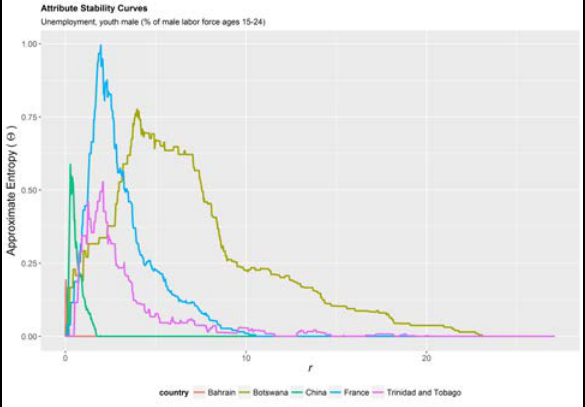
Figure 2. Attribute Stability Curves of Examples Trends